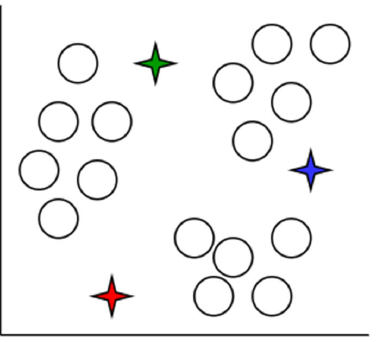
Figure 5. Step 2— K ‐ means: K = 3 Step 2: Initialize 3 centeroids.